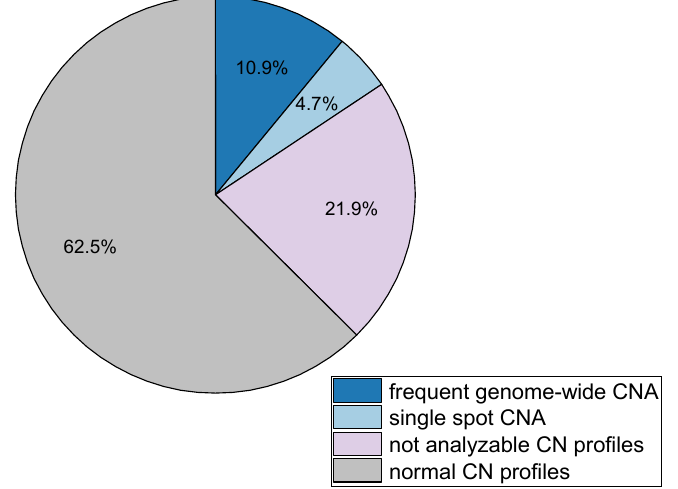
Figure 3. Copy number alteration frequency in all analyzed single